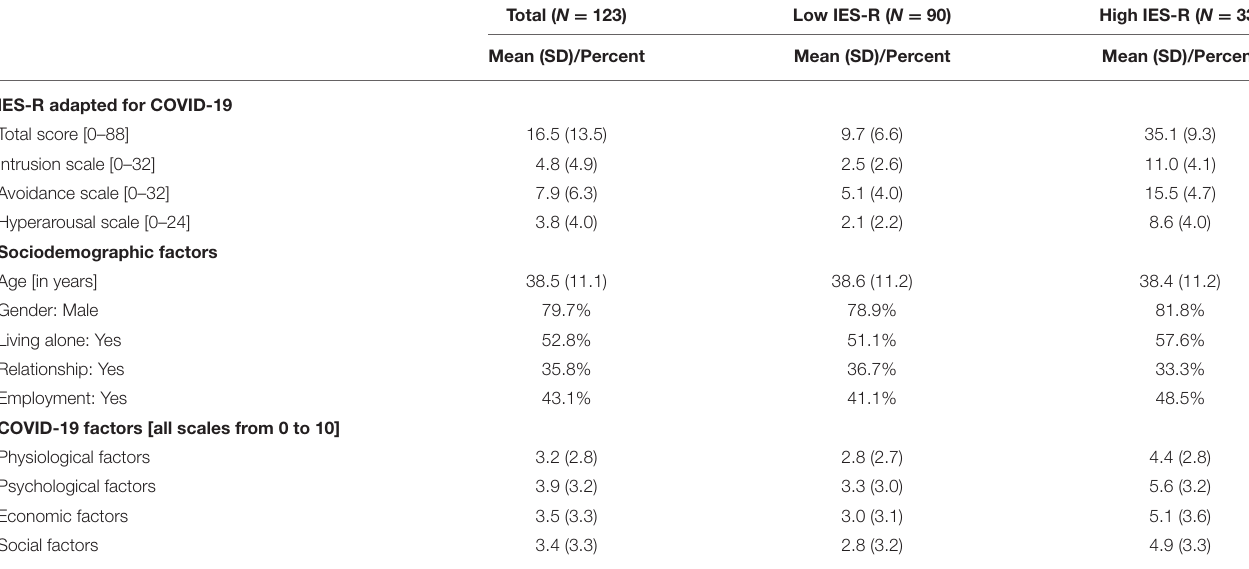
TABLE 1 | Descriptive statistics for all variables in the total sample and the two subgroups,